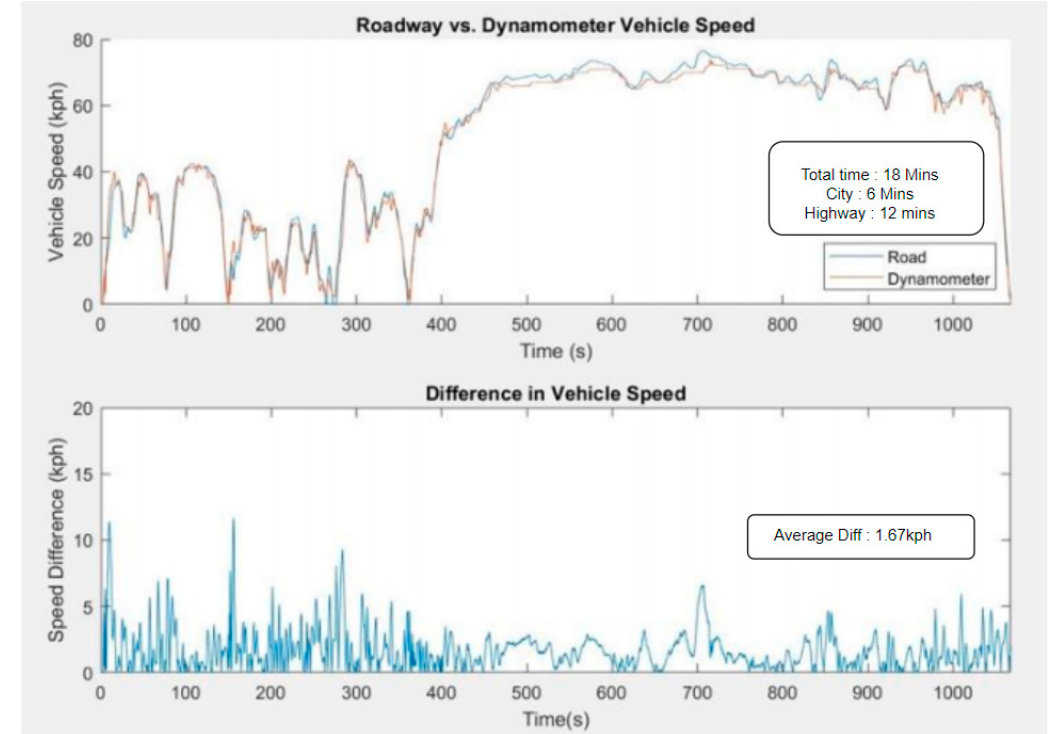
Figure 15. Road and dynamometer test vehicle speed and difference Adapted from [18], IEEE: 2020.